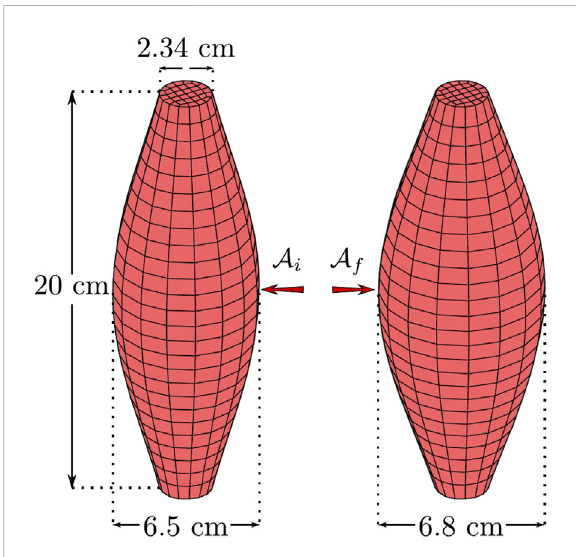
FIGURE 4 Comparison between muscle structure before and after the training